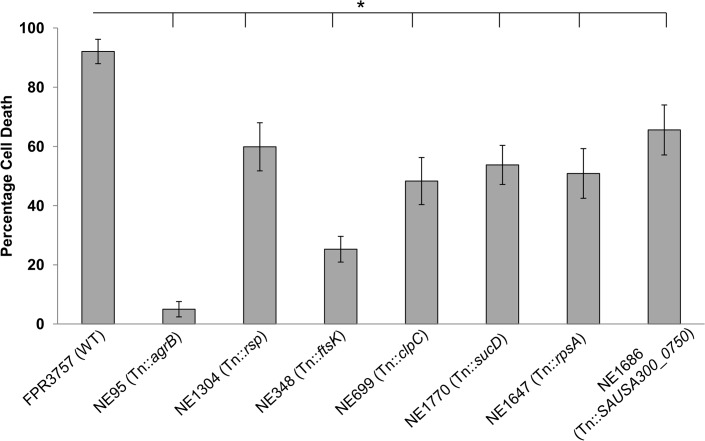
The identification of six novel toxicity-affecting loci.Transposon mutagenesis was used to functionally verify the role of loci associated with toxicity by genome-wide association study (GWAS; PLINK). Mean of six replicates are presented, error bars represent the 95% confidence intervals. The mutation in agrB is provided as a negative control. To access this data, see S2 Data.